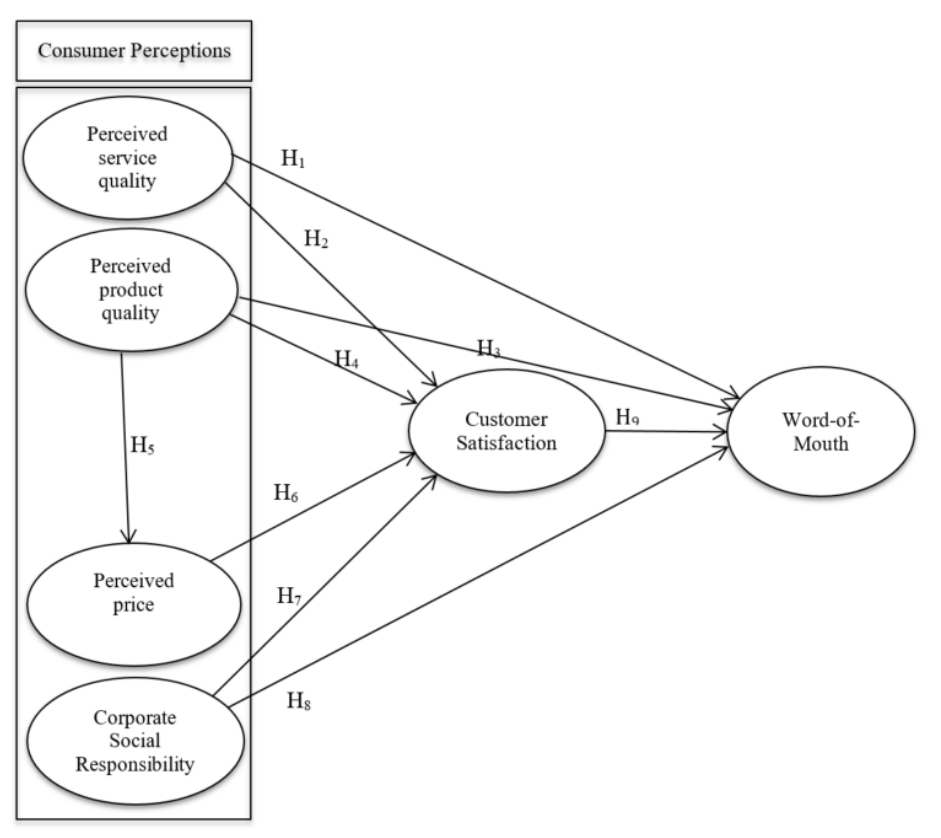
Fig. 1. The proposed conceptual